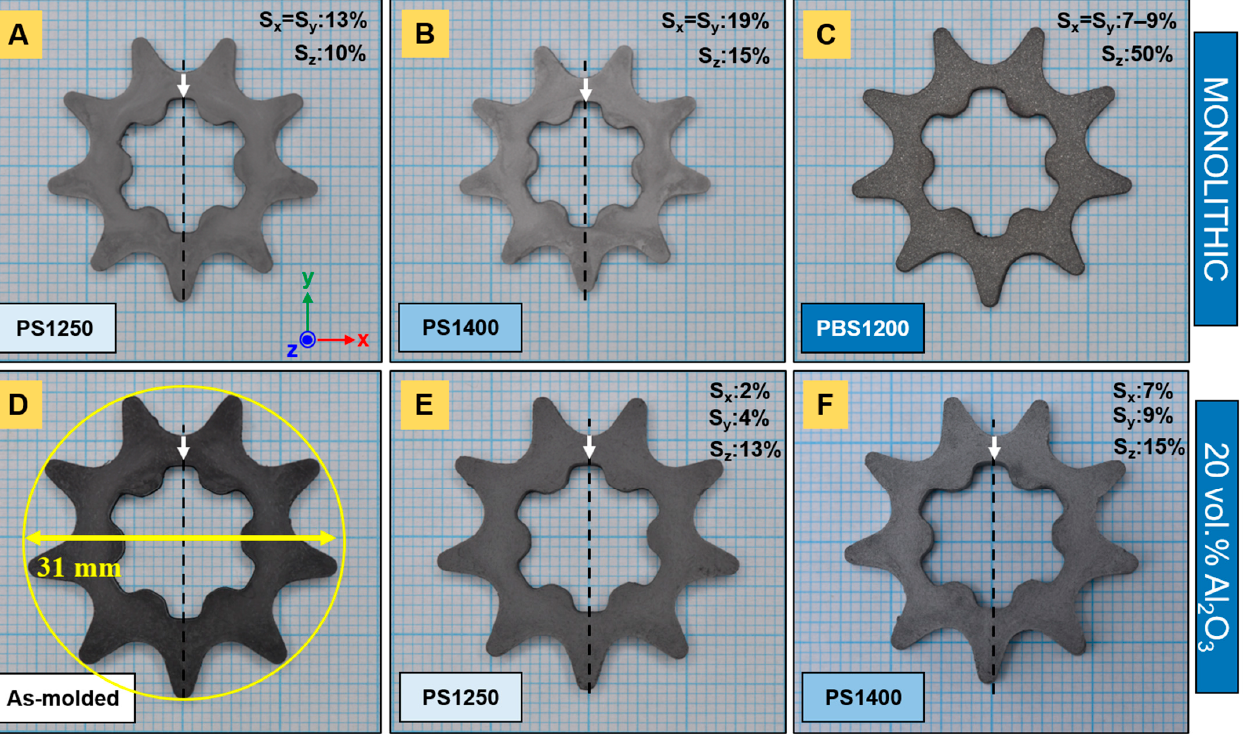
Figure 4. Sintered sprockets: ( A ) PS1250, ( B ) PS1400 and ( C ) PBS1200 of monolithic samples and ( D ) as-molded reference, ( E ) PS1250 and ( F ) PS1400 of N720 aluminosilicate fiber-reinforced (20 vol.%) composites. White arrows and dashed lines indicate the location of the gate and the axis parallel to the injection channel, respectively. Sintering shrinkage in each direction is given by the S values.